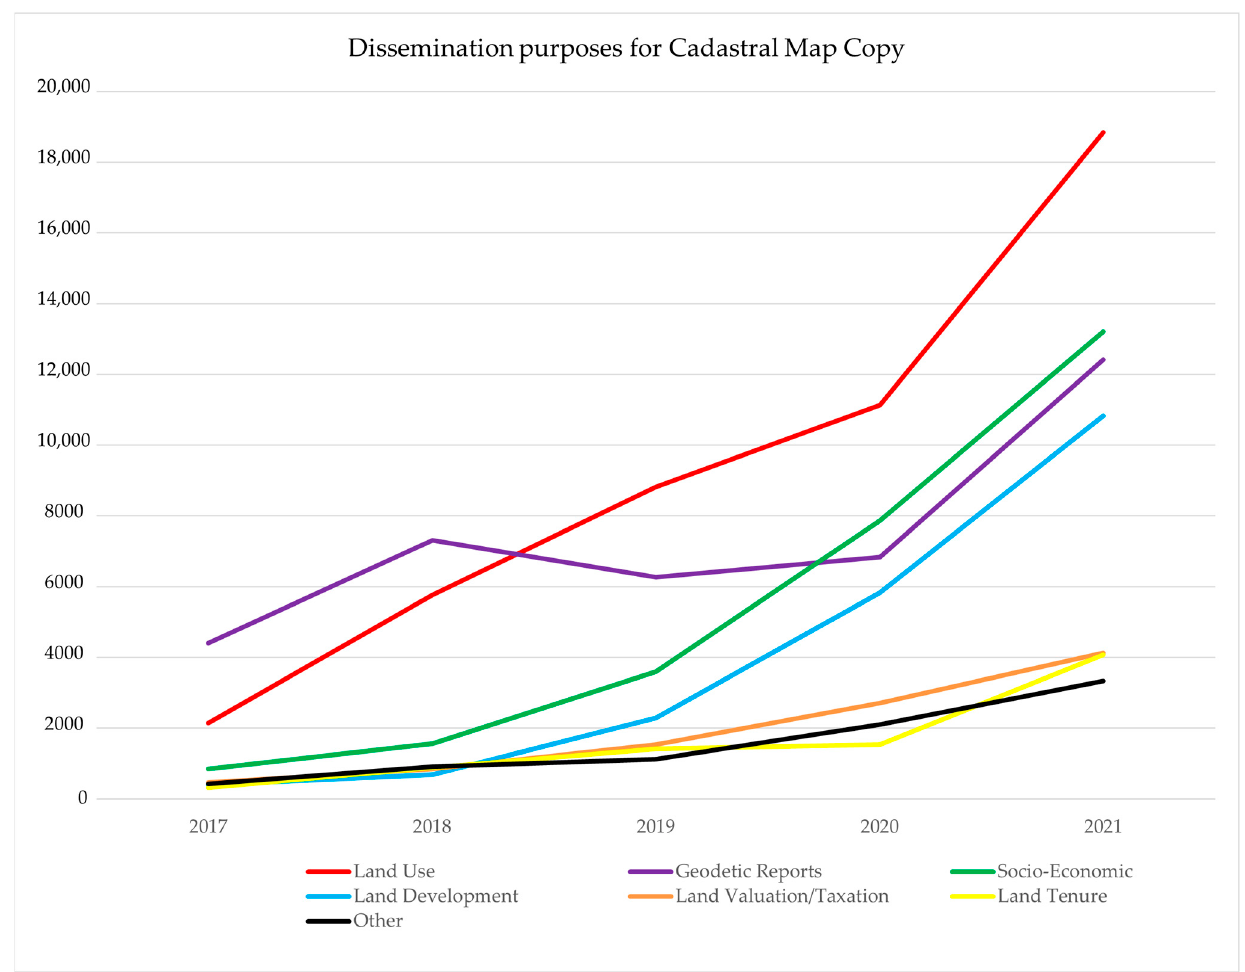
Figure 2. Statistical data for dissemination purposes of the Cadastral Map Copy in Croatia. Source: Own compilation.